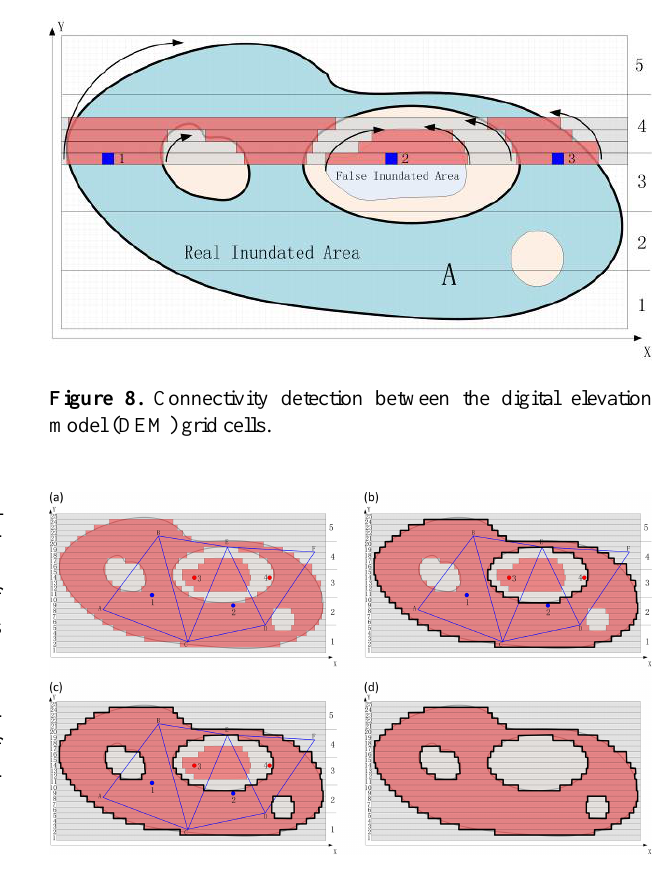
Figure 9. The scheme for run-length boundary tracing and the de- rived flood